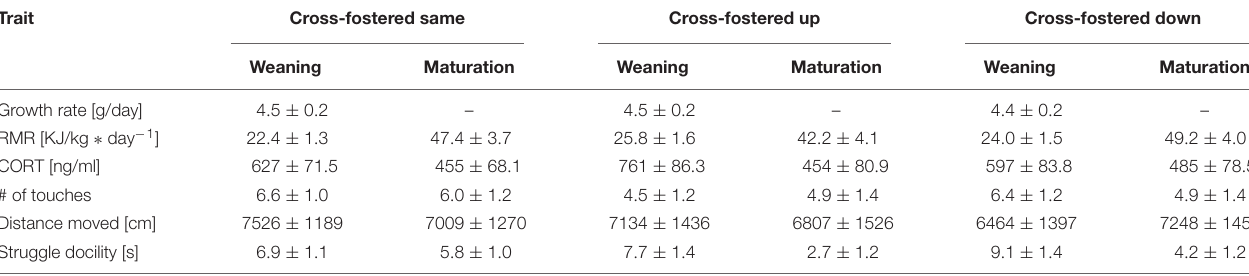
TABLE 2 | Mean estimates with their corresponding standard error of behavioral and physiological traits after cross-fostering. Trait